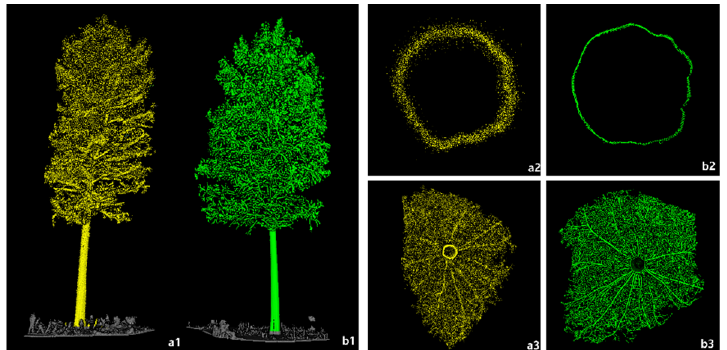
Figure 9. Comparison of data results between two devices for the same tree. Tree scanned using ( a1 ) BPLS and ( b1 ) TLS. Cross-section at breast height using ( a2 ) BPLS and ( b2 ) TLS. Bottom view of a standing tree using ( a3 ) BPLS and ( b3 ) TLS.